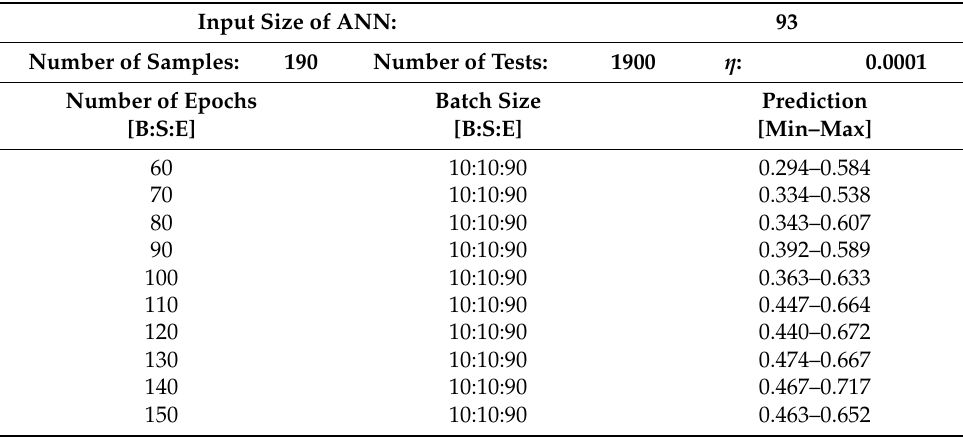
Table 9. Effectiveness of signal classification using CNN based on the TW vectors.